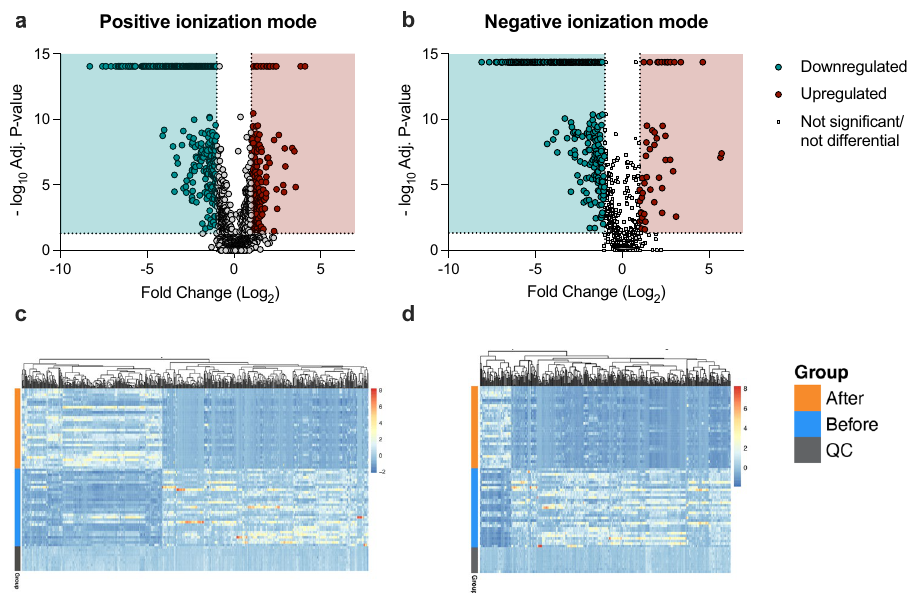
Figure 3. Differential metabolite features after stress. ( a – b ) Differential analysis of metabolite ratios between pigs in their familiar environment (Before) and 24 h after (After) the onset of stress. ( a ) Volcano plot of metabolite features from data acquisition in positive ionization mode. ( b ) Volcano plot of metabolite features from data acquisition in negative ionization mode. Each dot represents a metabolite feature. Significant upregulated metabolite features are in Red on the right (2 < fold change; Adj P < 0.05). Significant downregulated metabolite features are in Blue on the left (fold change < 0.5; Adj P < 0.05). ( c – d ) Heat map analysis of differential metabolite features (fold change < 0.5; 2 < fold change; Adj P < 0.05), ( c ) in both positive and ( d ) negative ionization modes. Each row represents a sample and each column a metabolite feature. Purple indicates that metabolite features were downregulated, and Yellow indicates that metabolite features were upregulated. Graphs a, b were created by GraphPad Prism (version 9.4.); Heat maps c, d were plotted by R (version 4.2.0), using R package pheatmap (version